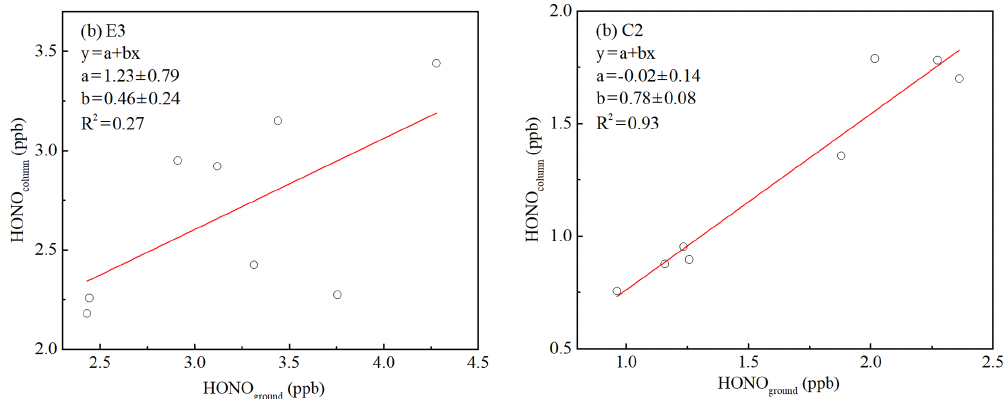
Figure 10. Orthogonal linear least squares correlation between the column-average concentration of HONO (the average HONO column concentration from 10 to 240m) and HONO measured from the ground level to 10ma.g.l. (above ground level). Column values were calculated for (a) E3 and (b)